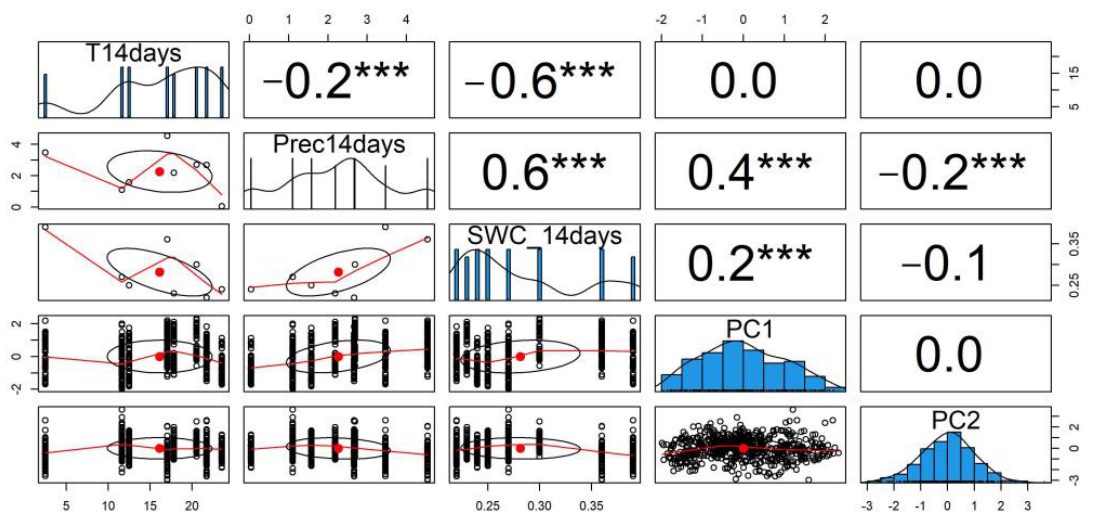
Figure 6. Correlation plot showing the data frame of correlations between the studied variables, classified within each component (PC1 and PC2). Significance was calculated on the basis of Spear- man’s correlation coefficients ( ρ ) (*** significant at the 1% level). Weather factors: T14days: mean air temperature 14 days before each sampling date, SWC_14days: average soil water content 14 days before each sampling date, Prec14days: rainfall sum 14 days before each sampling date.